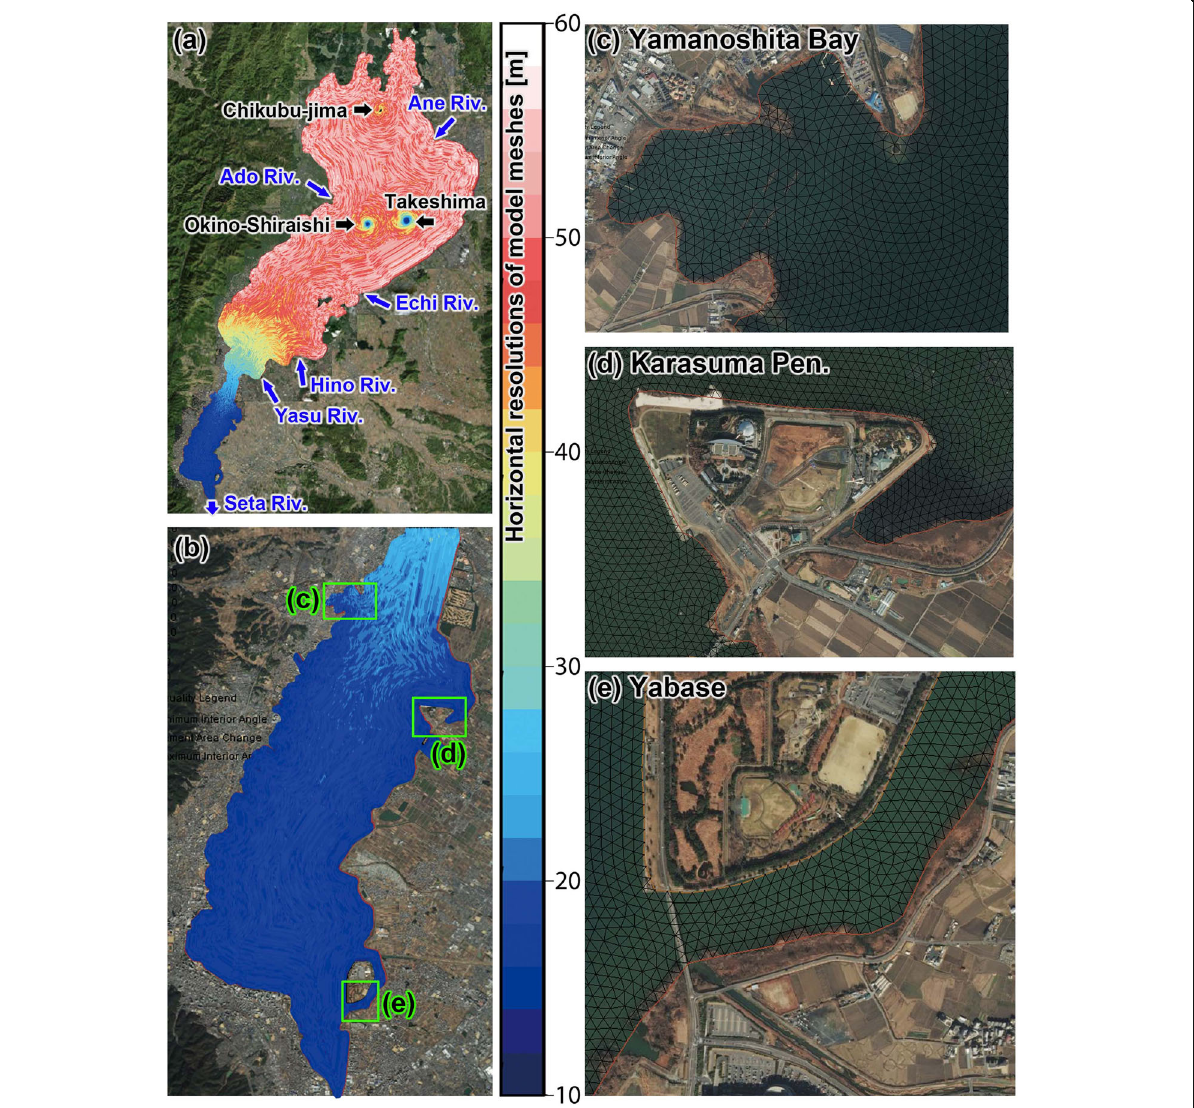
Fig. 4 Maps of the unstructured triangular grids in the FVCOM for a the whole basin of Lake Biwa and ( b ) the southern basin. The total numbers of triangular cells and nodes are 284,569 and 144,037, respectively. The colors indicate that the horizontal resolution of the grids (measured by the side length of each triangle) is 10 – 60 m and increases up to 10 – 20 m in the southern basin, for example, in c Yamanoshita Bay, d the Karasuma Peninsula, e the Yabase region, and three small islands in the northern